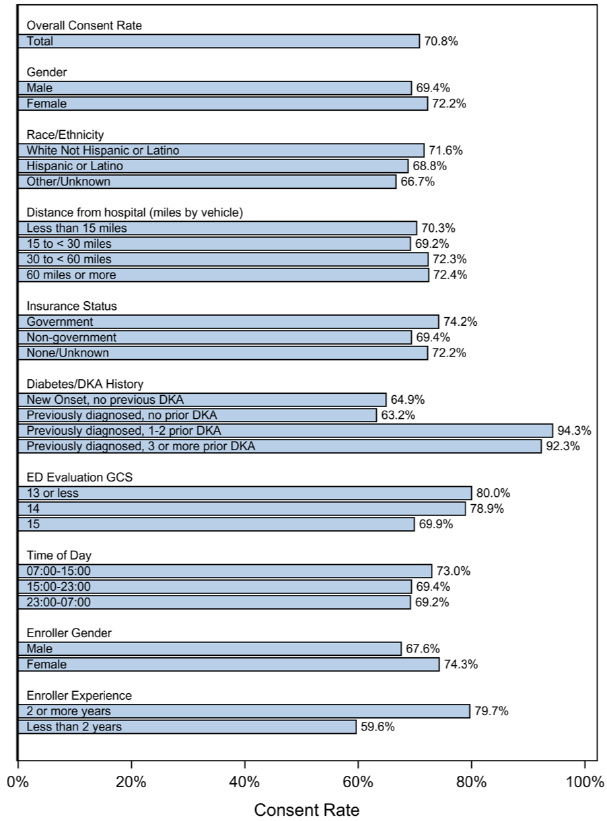
Figure. Consent rates by patient and enroller characteristics. DKA , diabetic ketoacidosis; ED , emergency department, GCS , Glasgow Coma